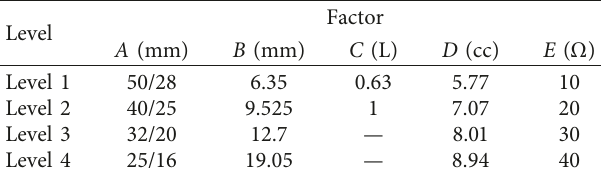
Table 7: Simulation test